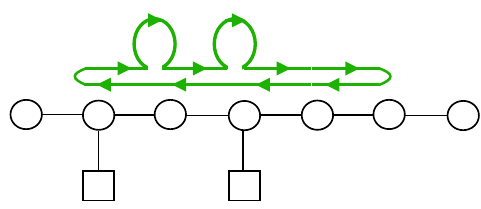
Figure 5 . Mixed-branch operators are gauge-invariant products of chiral (cid:12)elds from both hyper- multiplets and vector multiplets. The former are linear string bits while the latter, in the adjoint representation of the gauge group, are denoted by bubbles. The closed string in the (cid:12)gure has 8 linear segments and 2 bubbles, and transforms in the representation B 1 [0] (4;2) 6